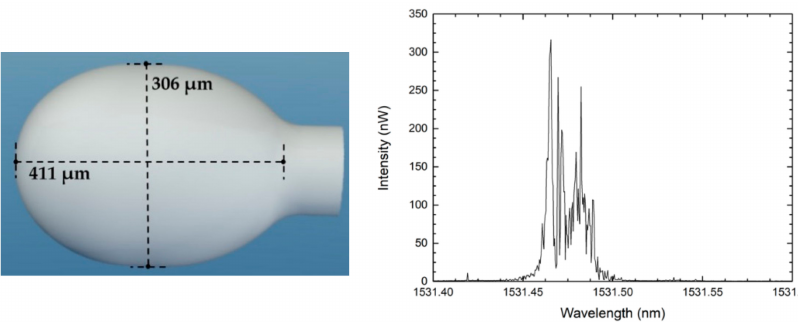
Figure 5. Schematic diagram of a stadium-shaped microsphere and output signal, when using the microsphere in the ring structure illustrated in Figure 4.